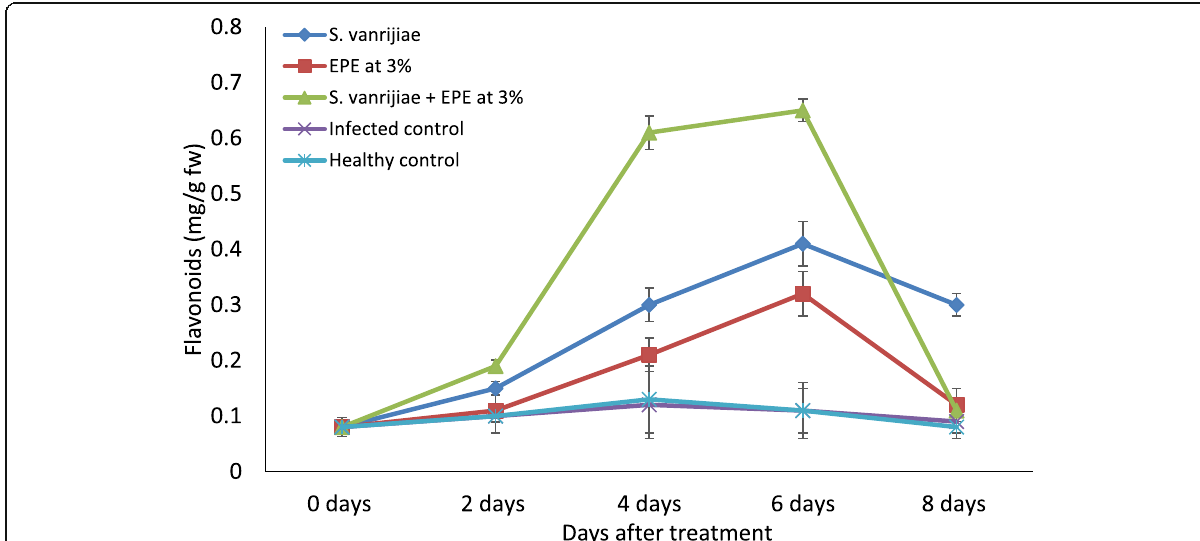
Fig. 6 Time course of flavonoids (mg/g fw) in extracts from lemon cv seedless limes tissues treated or not with S . vanrijiae and 3% EPE in mixture. All the values are the means of four replicates ±